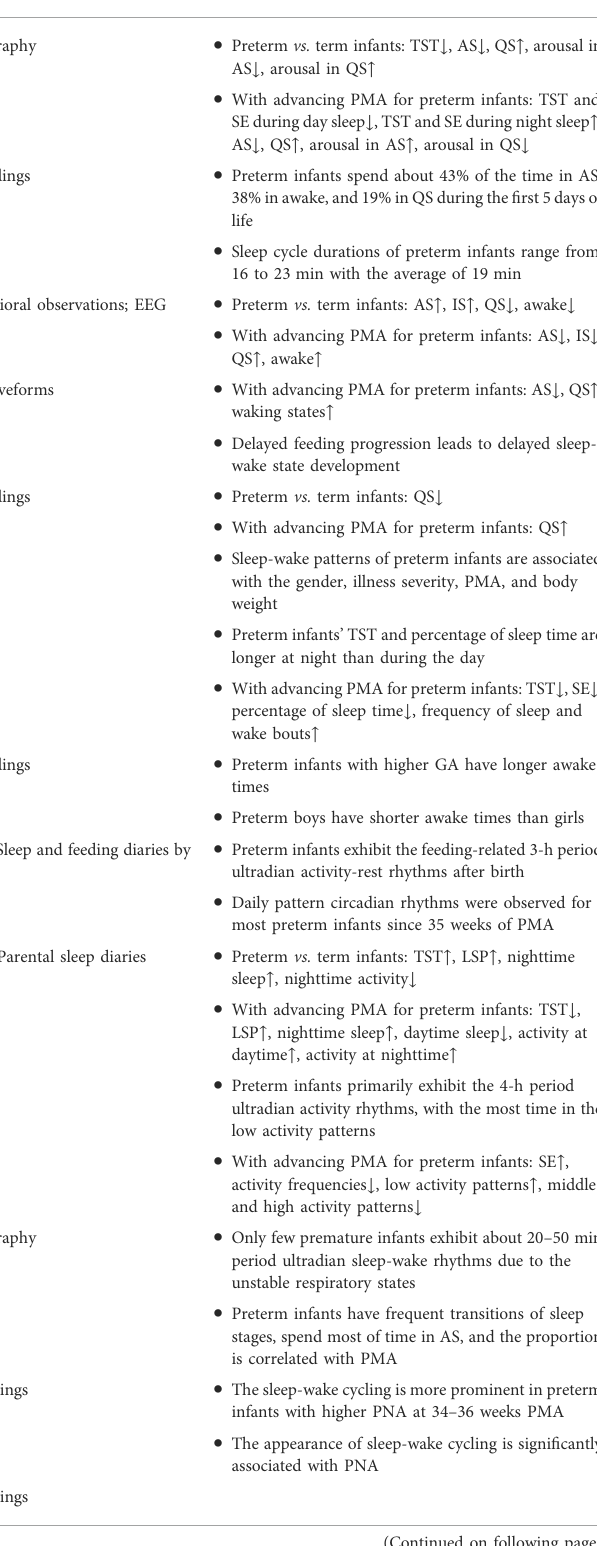
TABLE 1 Studies about the sleep-wake rhythms in preterm infants.